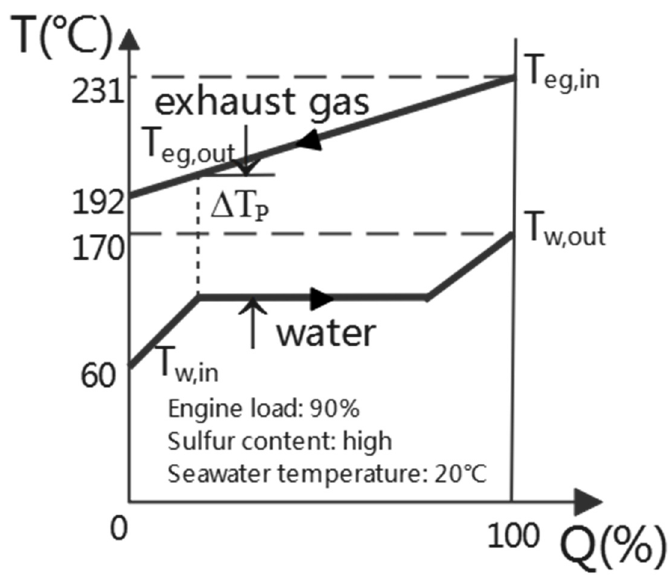
Figure 2. Schematic diagram of boiler heat exchanging process.